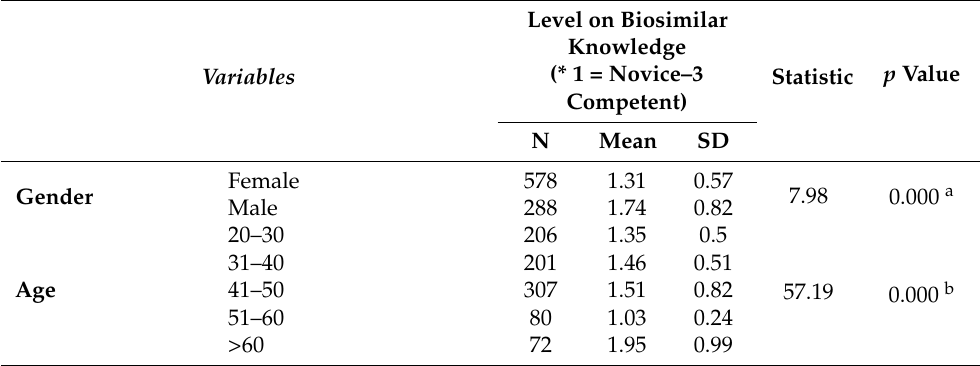
Table 2. The level of knowledge about biosimilar drugs vs. sociodemographic data.